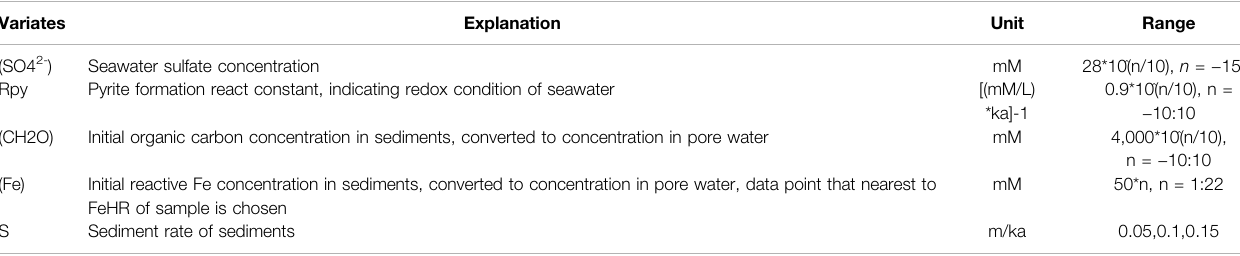
TABLE 2 | List of parameters used in the model. Variates